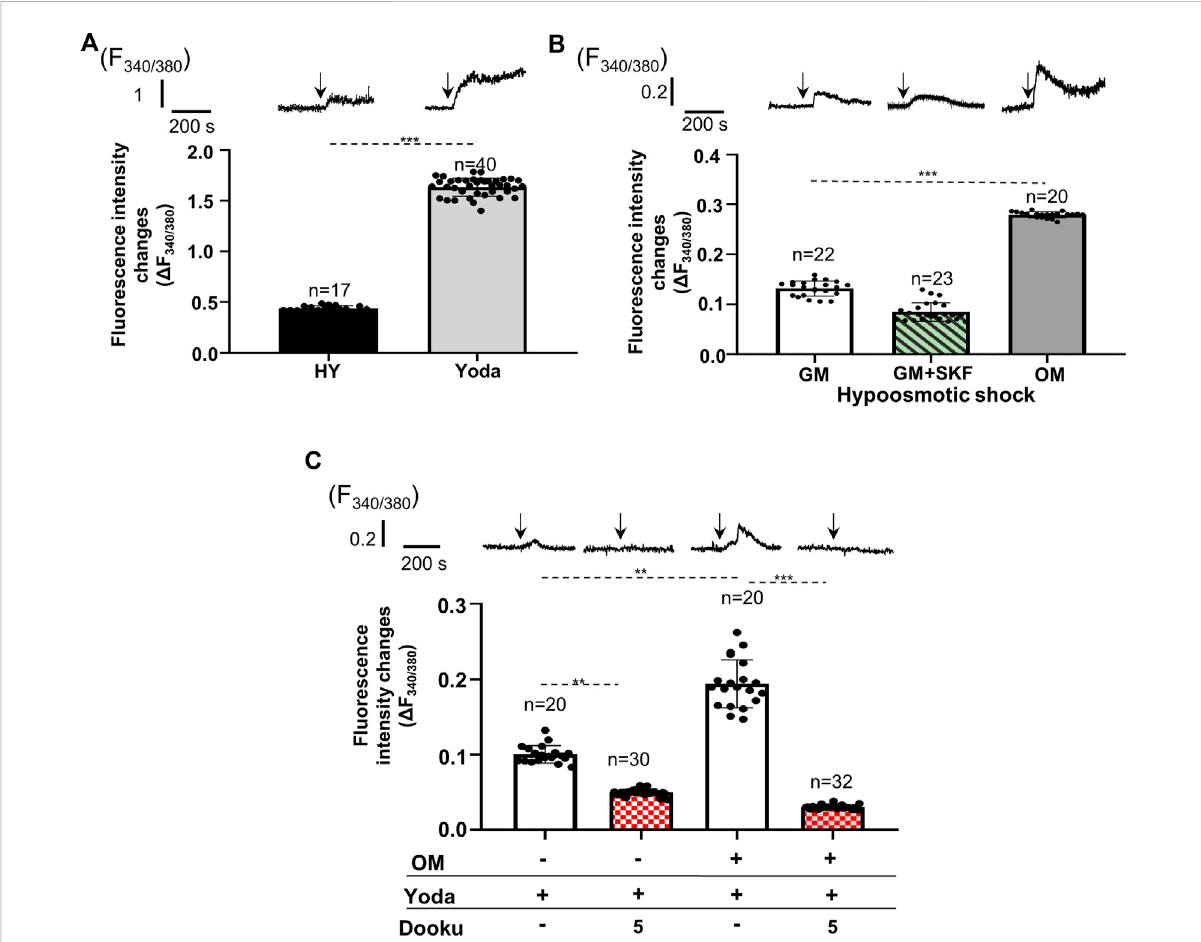
FIGURE 2 Alteration of Ca2+ transients evoked by pharmacological and mechanical activation (due to cell volume regulation) of Piezo1 channels on controlandcalci fi edsmoothmusclecells.RepresentativetransientsandmeanofFura-2 fl uorescenceintensitychangesmeasuredonindividualcells are shown. (A) Hypoosmotic shock (HY) and Yoda1 administration evoked Ca 2+ transients on smooth muscle cells isolated from mouse abdominal artery. (B) Calcium transients elicited by hypoosmotic shock on control (GM), SKF 96365 treated (GM + SKF) and calci fi ed (OM) HAoSMCs. (C) Yoda1 induced calcium transients on control (GM) and calci fi ed (OM) HAoSMCs. Effect of additional 5 µM Dooku1, which reversibly and selectively antagonizes Yoda1 effect on Piezo1 activity is presented by patterned columns. Data are presented as mean ± SEM, ** p < 0.01, *** p < 0.005. The arrows indicate the time of the appropriate